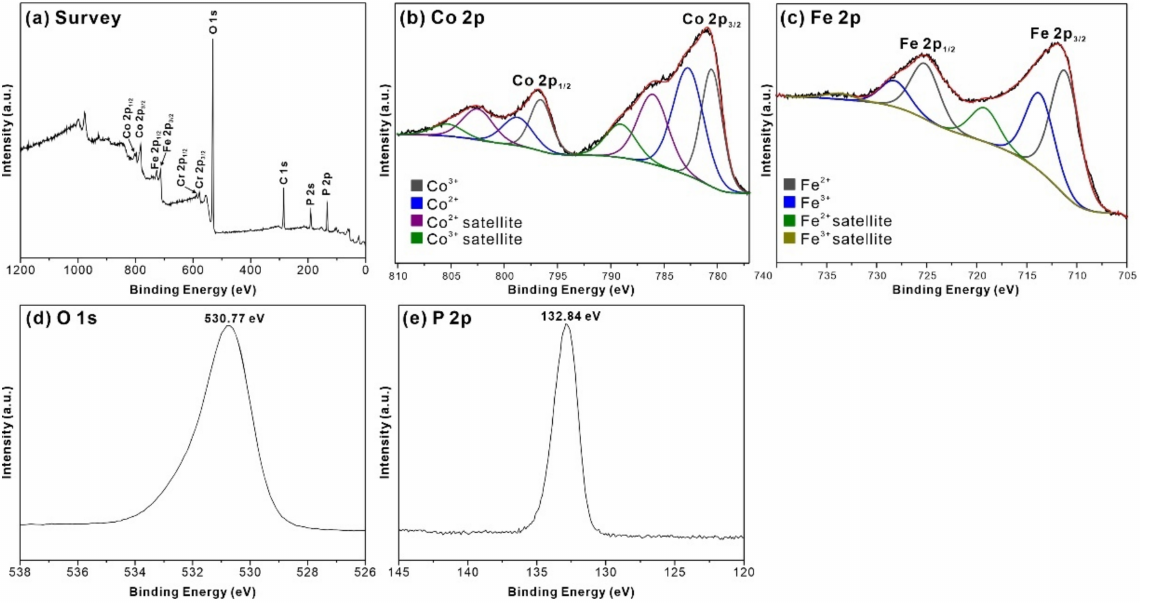
Figure 4. ( a ) XPS survey spectrum for iron phosphate oxide hydroxide crystal. XPS spectra of iron phosphate oxide hydroxide crystal in the ( b ) Co 2p, ( c ) Fe 2p, ( d ) O 1s, and ( e ) P 2p